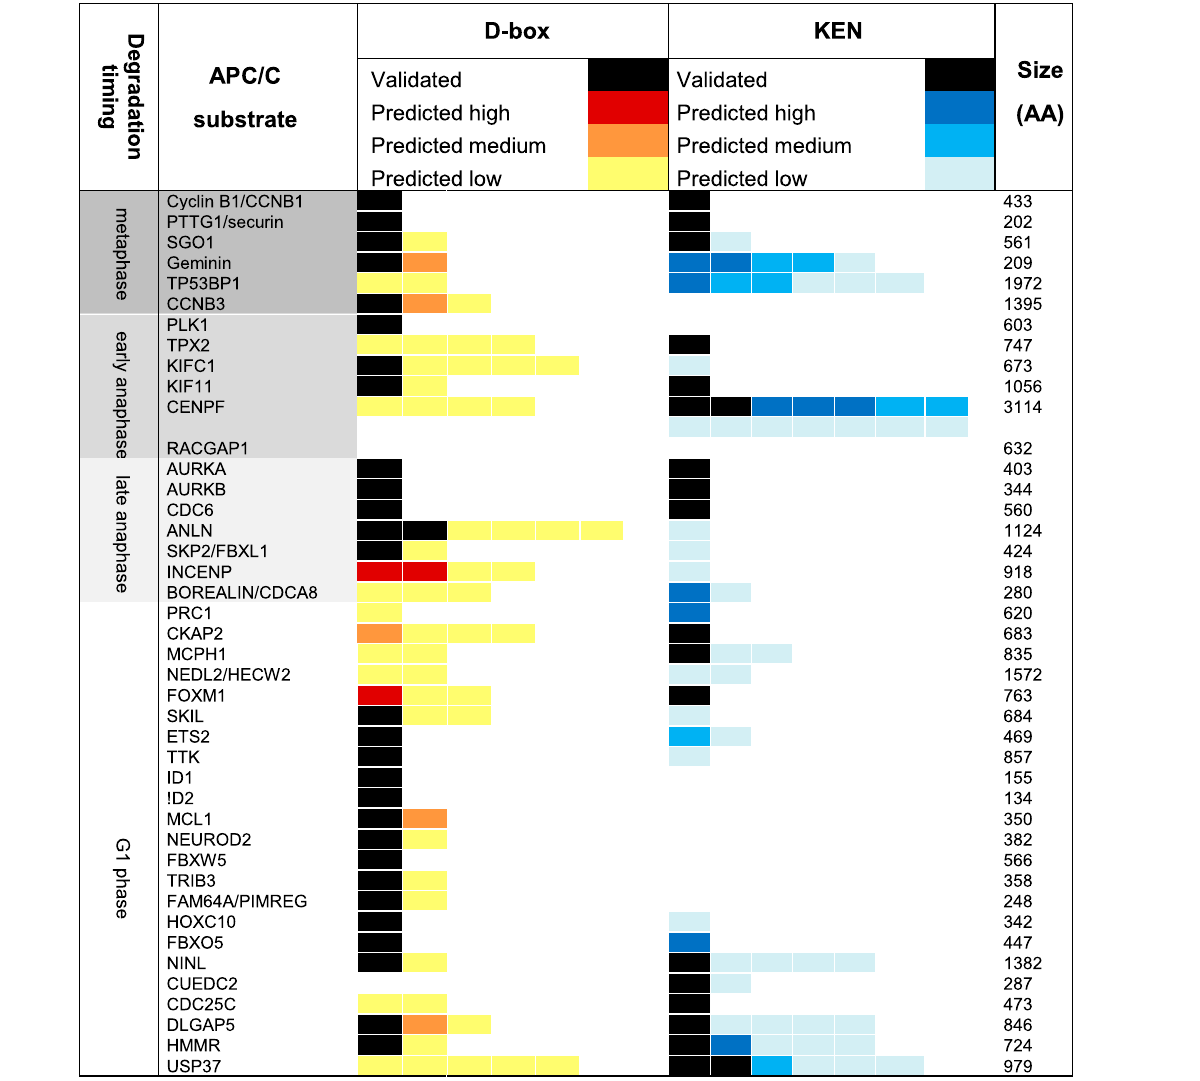
Onlysubstratestargetedatmitoticexitareincluded.OurstudydoesnotincludeAPC/CsubstratesdegradedwhilsttheSACisactive(suchascyclinA,Nek2A,andKIF18),showntohave additionalD-box-andKEN-independent dockingsitesonAPC/C.Foreachsubstrate,degronsvalidatedintheliteratureareincluded(blacktabs),alongsidedegronspredictedbyProViz (one tab per degron). Predicted degrons are included where disorder score ≥ 0.4 and similarity to consensus motif scores > 0.5 (low), > 0.8 (medium) or > 0.85 (high).